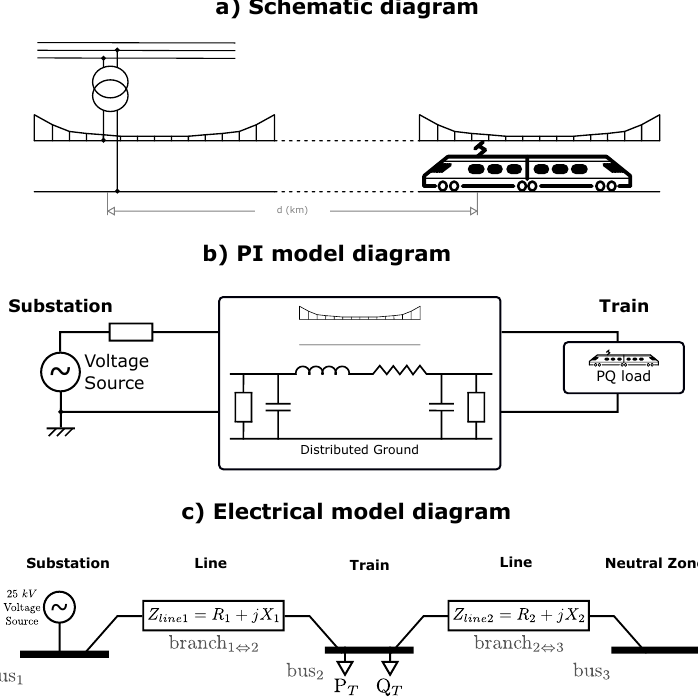
Figure 4. Framework of the 1 × 25 kV models: ( a ) illustration of physical representation; ( b ) PI model diagram; ( c ) considered bus-branch model for MatPower (Note: the traction transformer is not considered in this